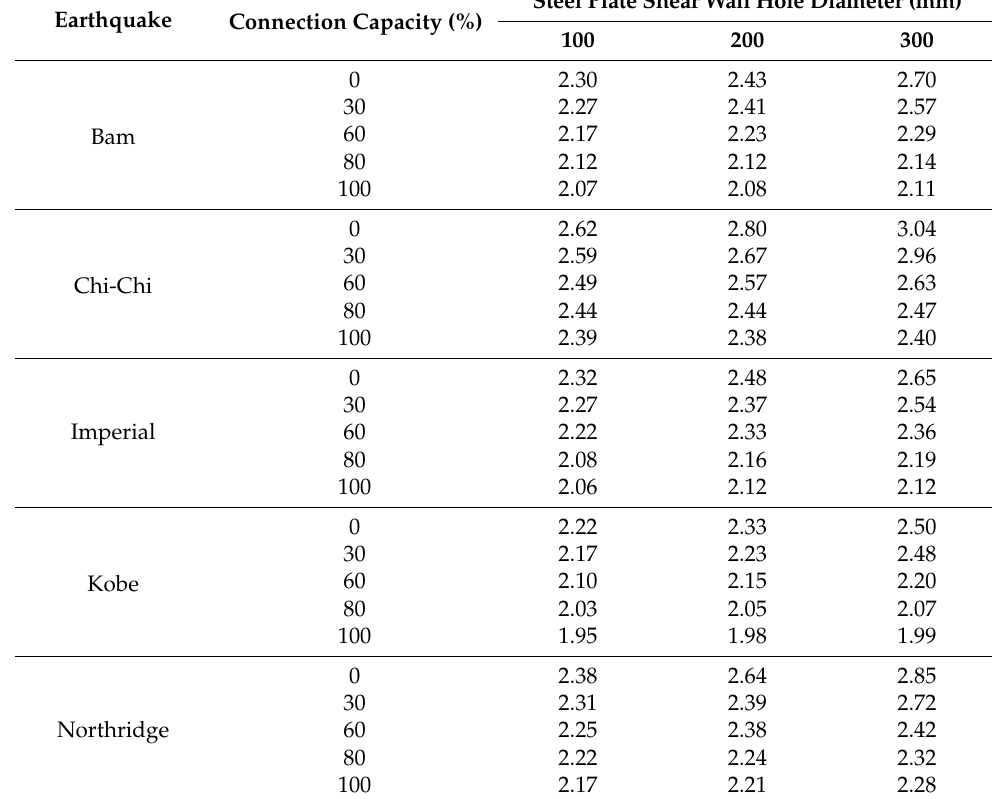
Table 8. Maximum story drift of 10-story